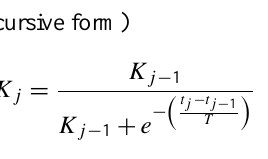
Fig. 1. Examples of application of the SMAR to a time series of surface soil moisture ( s 1 , relative saturation of the first 10cm of soil) for different values of soil water losses (A) , rooting depth ratios (B) , and soil textures (C) . The function s ∗ only one parameter in (A) and (B) ( V and Zr 2 , respectively) and assigning different soil textures in (C) using the soil parameters reported in Table 1. In each plot, the remaining parameters have been assigned using the following set of reference values n 1 = n 2 = 0 . 437, s w2 = 0 . 06, s c2 = 0 . 14, V = 2cmday − 1 , Zr 1 = 10cm, and Zr 2 = 90cm (measurements are taken from the station of Sevilleta – lat. 34 ◦ 21 0 N, long. 106 ◦ 41 0 W; New Mexico,